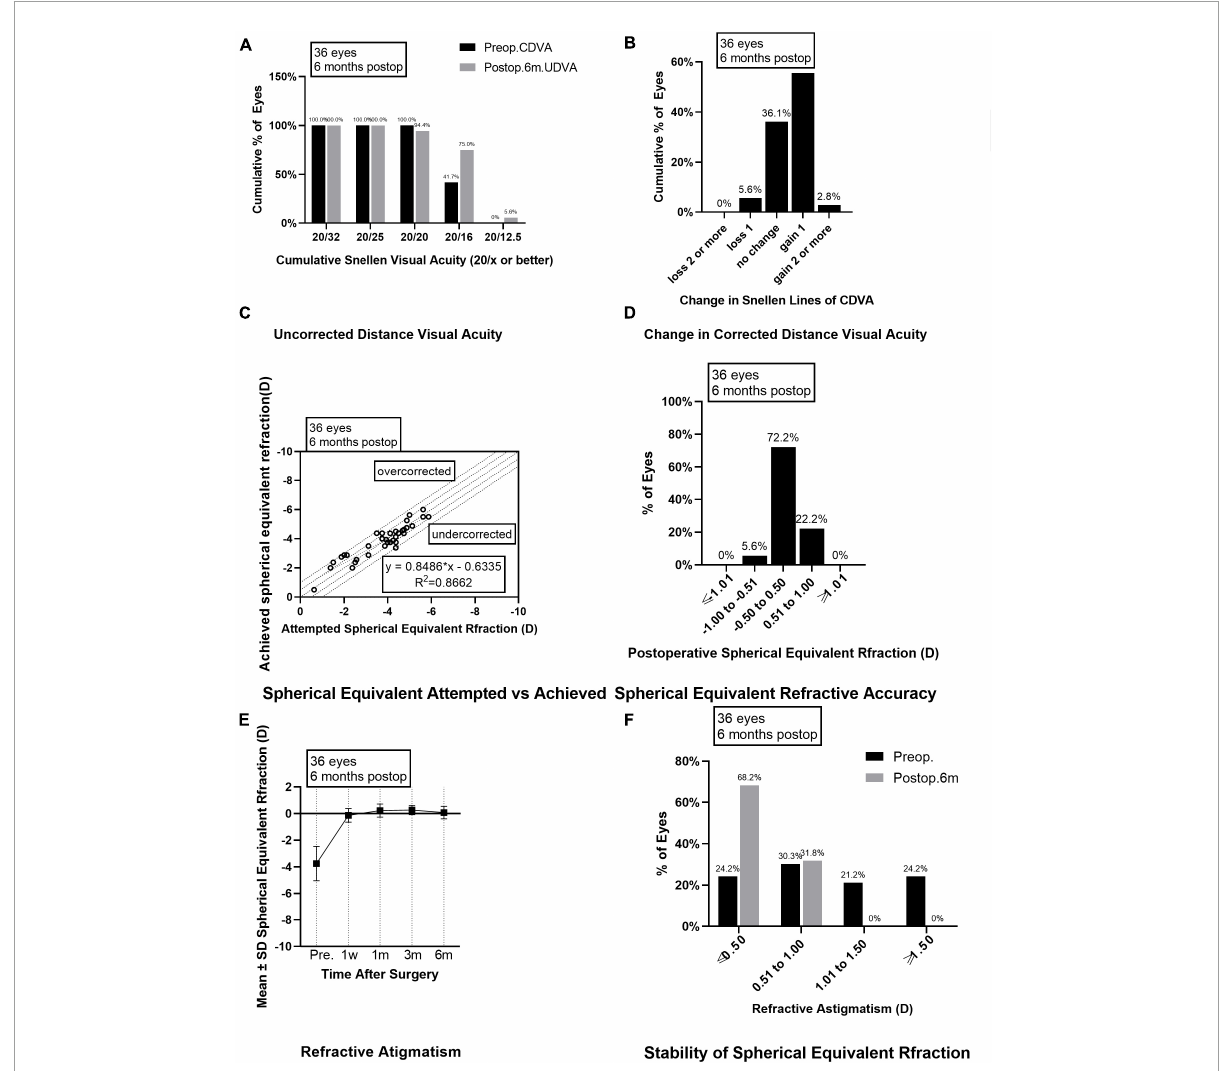
FIGURE2 Outcomes of group B after SMILE surgery. (A) Cumulative percentage of preoperative CDVA and postoperative UDVA in group B at 6 months follow-up; (B) Change in CDVA in group B at 6 months follow-up; (C) Achieved versus attempted change in SE at 6 months follow-up in group B; (D) Accuracy of SE refraction in group B at 6 months follow-up; (E) Stability of SE in group B at 1 week, 1 month, 3 months and 6 months after surgery; (F) The percentage of preoperative postoperative refractive astigmatism in group B at 6 months follow-up. CDVA, corrected distance visual acuity; UDVA, uncorrected distance visual acuity; SE, spherical